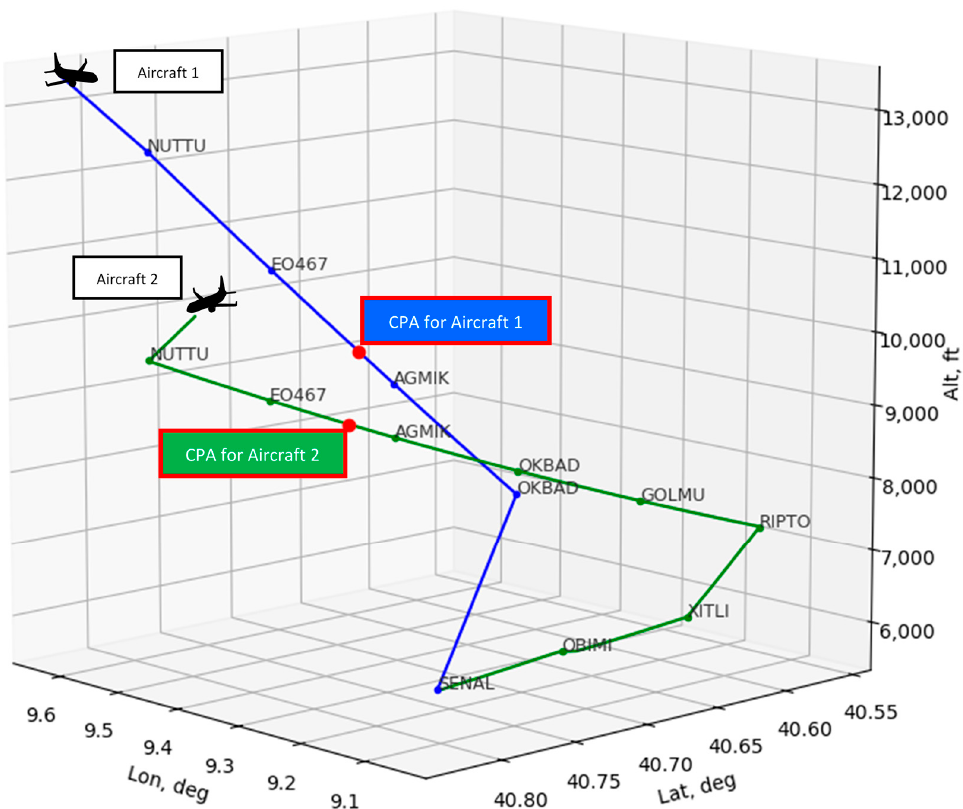
Figure 4 . Pictorial view of the three-dimensional CPA. Figure 4. Pictorial view of the three-dimensional